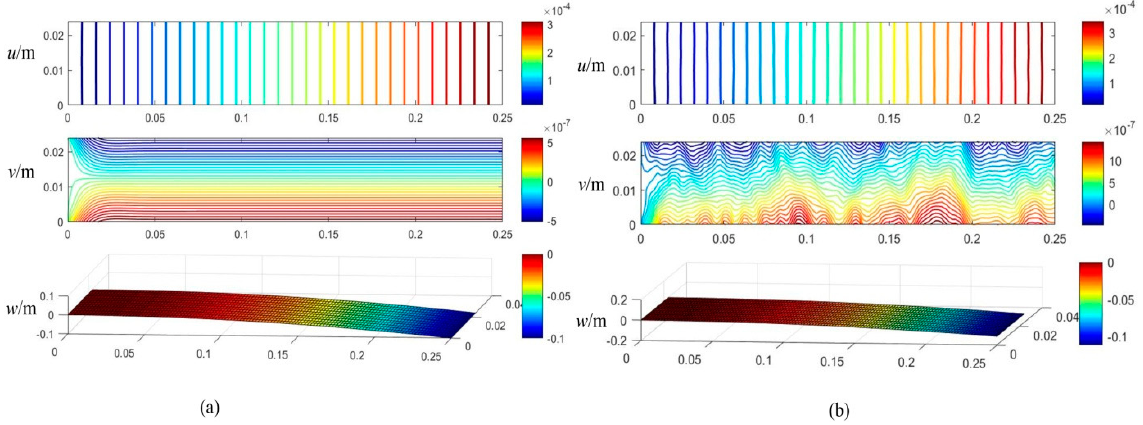
Figure 7. Structural response with bending moment M y ( a ) without wrinkles and ( b ) with randomly distributed wrinkles.